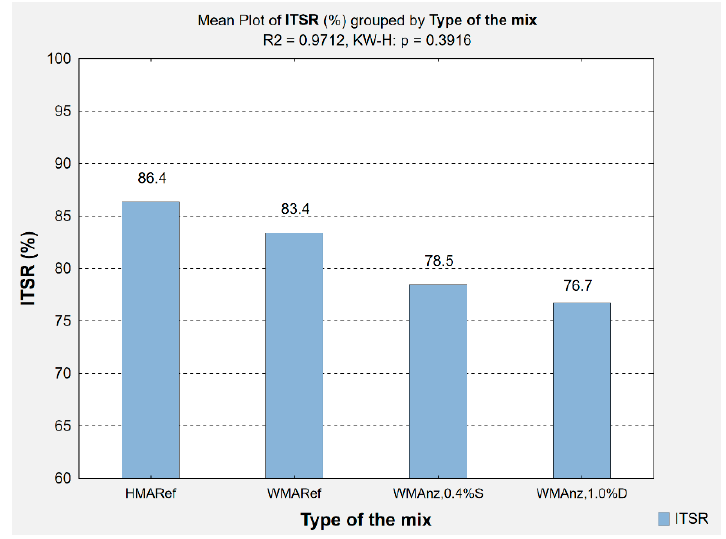
Figure 12. Results of water and frost susceptibility indices ( ITSR ) determination in the Marshall samples produced from the investigated AC 16.